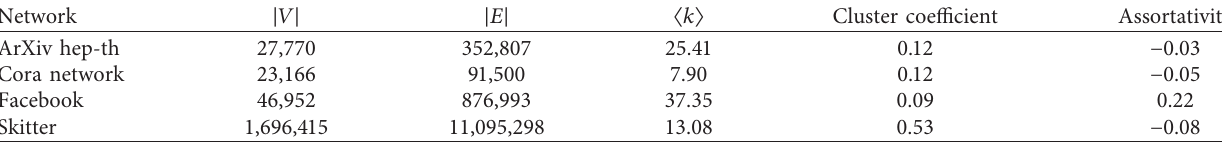
Table 1: Topology index of the four